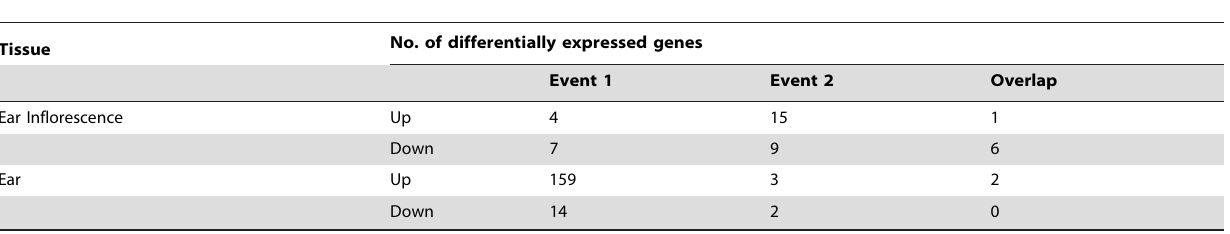
Table 4. The number of differentially expressed genes in ear inflorescence and ear of ATHB17 events relative to control.